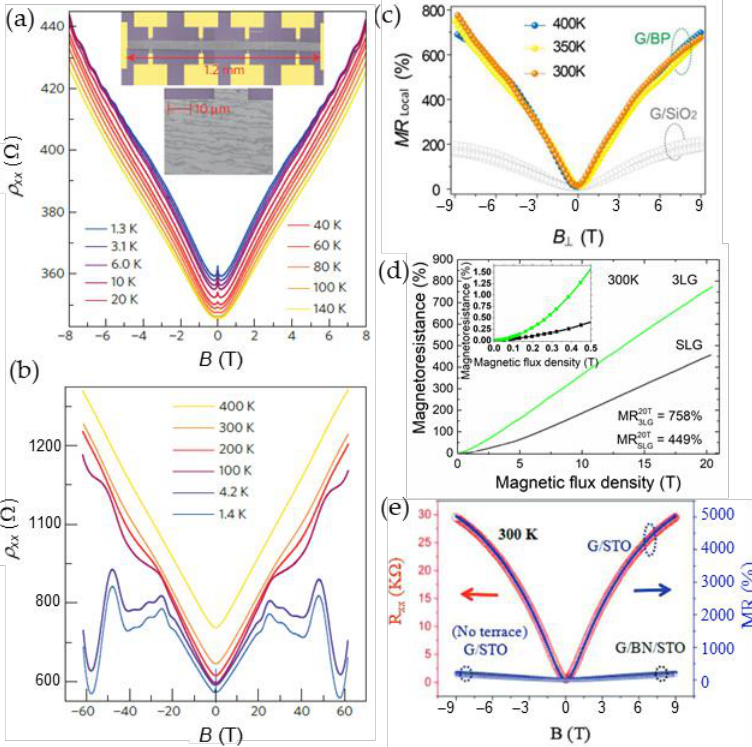
Figure 17. ( a ) Linear MR (resistivity) measured in large-area bilayer graphene. Inset presents the SEM image of a Hall bar together with a close-up that shows mainly bilayer, but also trilayer strips as darker shaded areas; ( b ) MR (resistivity) measured in pulsed magnetic fields up to 62 T at different temperatures (data have been vertically shifted by 20 for better visibility). Reprinted with permission from [128]. Copyright © 2015, Nature Publishing Group; ( c ) magnetoresistance ( MR ) of graphene/black phosphorus (G/BP) and G/SiO 2 devices at various temperatures. Reprinted with permission from [123]. Copyright 2018 American Chemical Society; ( d ) the MR dependence on magnetic field (pulsed) up to 21 T of single- and three-layer graphene at 300 K. The inset: The MR ( B ) dependence up to 0.5 T for single- and three-layer graphene. Reprinted from [12]. Copyright © 2015, Nature Publishing Group; and ( e ) longitudinal resistance R xx and MR as a function of a magnetic field near the charge neutrality point (CNP) for G/STO with terraces (red and blue lines), G/STO without terrace (blue dashed line), and G/BN/STO (black dashed line). Reprinted with permission from [124]. Copyright 2020 Wiley-VCH GmbH.